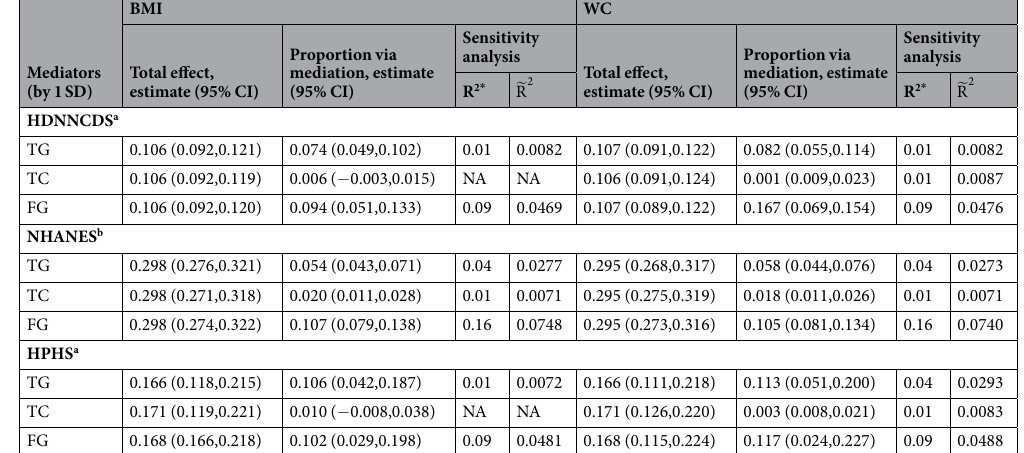
Table 5. Effect of BMI or WC on insulin resistance with mediation of established biomarkers in the Harbin Cohort Study on Diet, Nutrition and Chronic Non-Communicable Diseases (HDNNCDS, 2010–2012), the US National Health and Nutrition Examination Survey (NHANES) and in the Harbin People’s Health Study (HPHS, 2008–2012) Abbreviation: BMI, body mass index; WC, waist circumference; SBP, systolic blood pressure; DBP, diastolic blood pressure; TG, triglyceride; TC, total cholesterol; FG, fasting glucose; PG, 2-h postprandial glucose; FI, fasting insulin. a Adjusted for age, sex, current smoking, current drinking, exercise regularly, type 2 diabetes, cardiovascular disease, family history of hypertension, and total energy intake. b Adjusted for age, sex, ethnicity, exercise regularly, current smoking, current drinking, diabetes mellitus, cardiovascular disease, and total energy intake. R 2 * , the proportion of residual variances and of original variances that were explained by the omitted confounding.